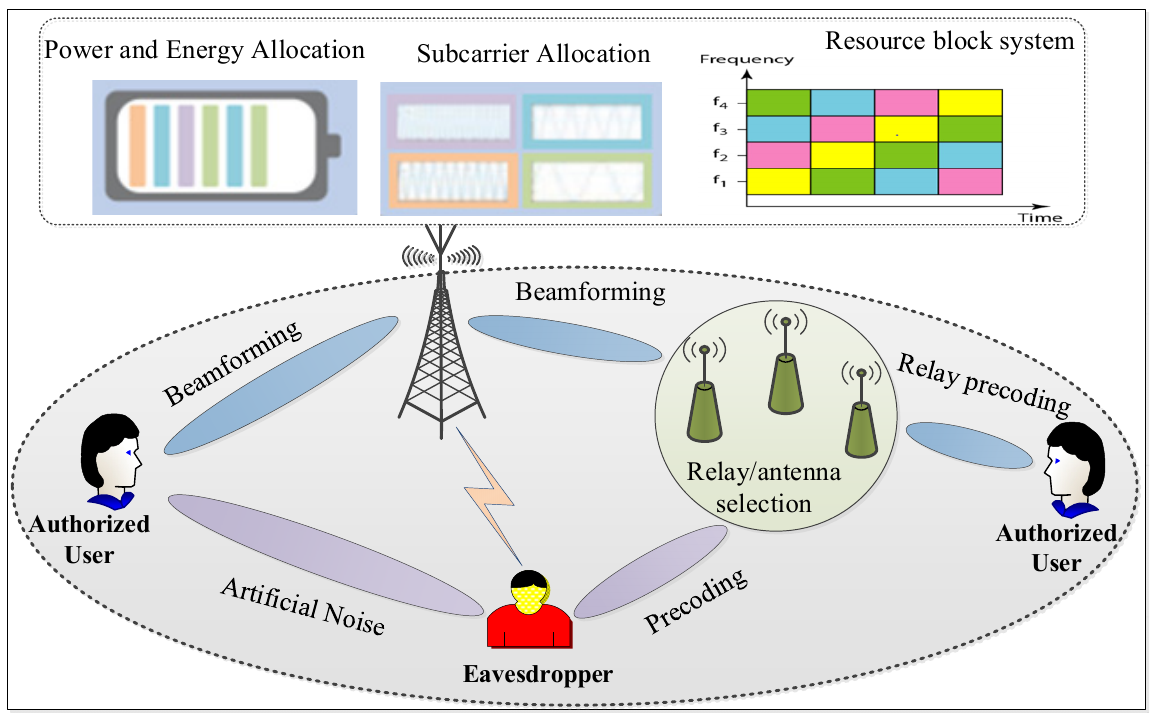
Figure 9. An illustration of multi-dimensional security and resource management within a multi- service wireless network.